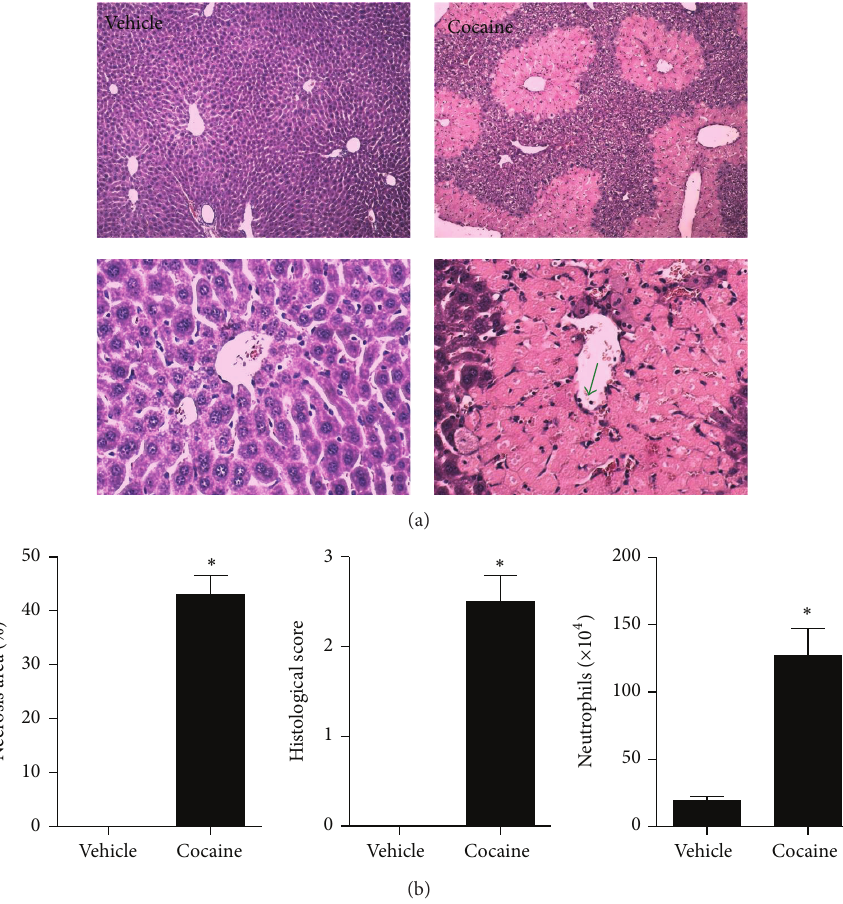
Figure 2: Histopathological assessment of cocaine-induced liver injury. (a) Liver histology (H&E) showing that while control mice have a healthyliverarchitectureandabsenceofnecrosis,cocaine-treatedmicehadseveralnecroticareaswithleukocyteinfiltration(greenarrow).(b) Digital quantification of necrotic areas using ImageJ, histopathological score, and neutrophil infiltration (assessed by MPO levels) confirmed severe liver inflammation and necrosis induced by cocaine. ∗ Statistical significance in comparison to controls ( 𝑃 < 0.05 ). A 10x objective was used during imaging. One-way ANOVA with Tukey’s post hoc test. Data are expressed as mean ± S . E . M ( 𝑛 = 6